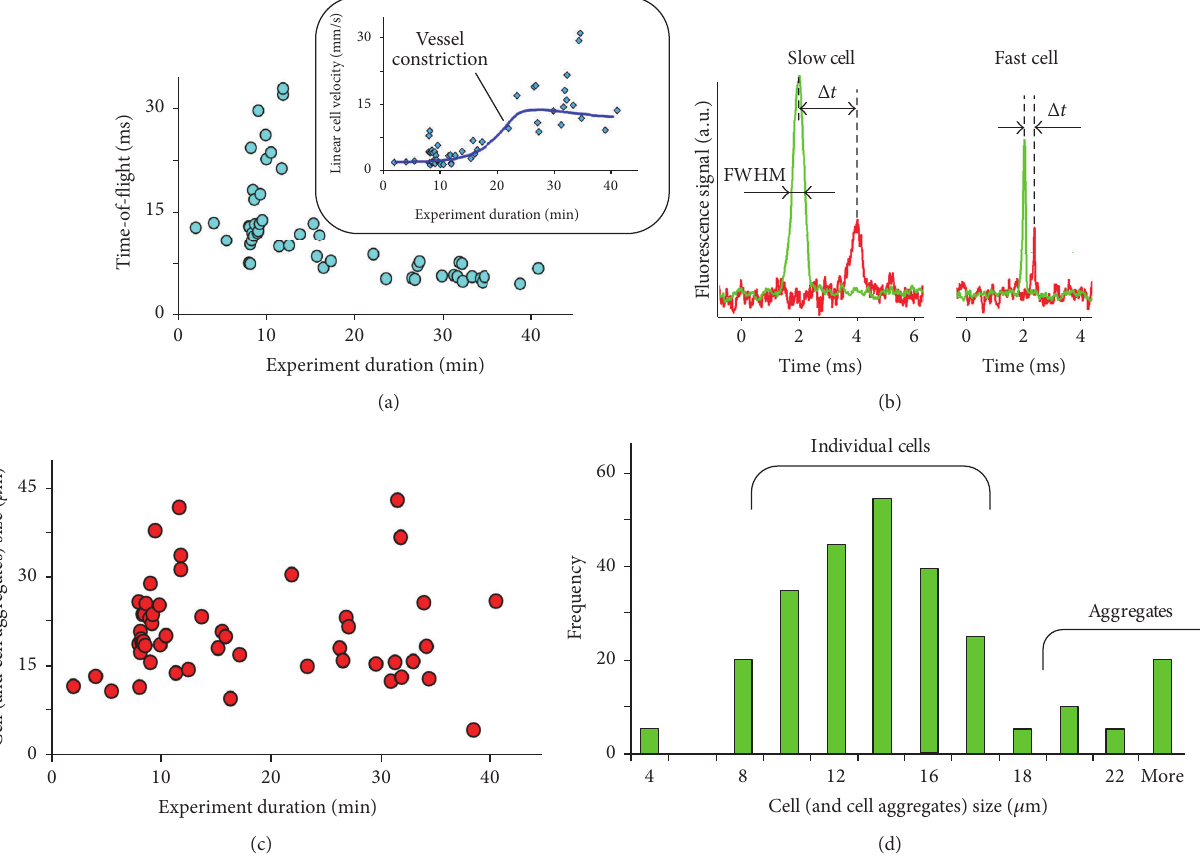
Figure 5: CTC size analysis using two-color two-beam in vivo PAFFC platform. (a) Time-of-flight data for cells after injection in a slightly constricted artery. Inset shows linear cells velocity measured from time delay ( Δ𝑡 ) between signals. (b) Typical fluorescence signals from slow (left) and fast (right) cells. Arrows indicate FWHM and Δ𝑡 delay parameters acquired for each cell. (c) Cell (and cell aggregates) size calculated from time-of-flight and cell velocity data. (d) Cell (and cell aggregates) size distribution histogram calculated from in vivo